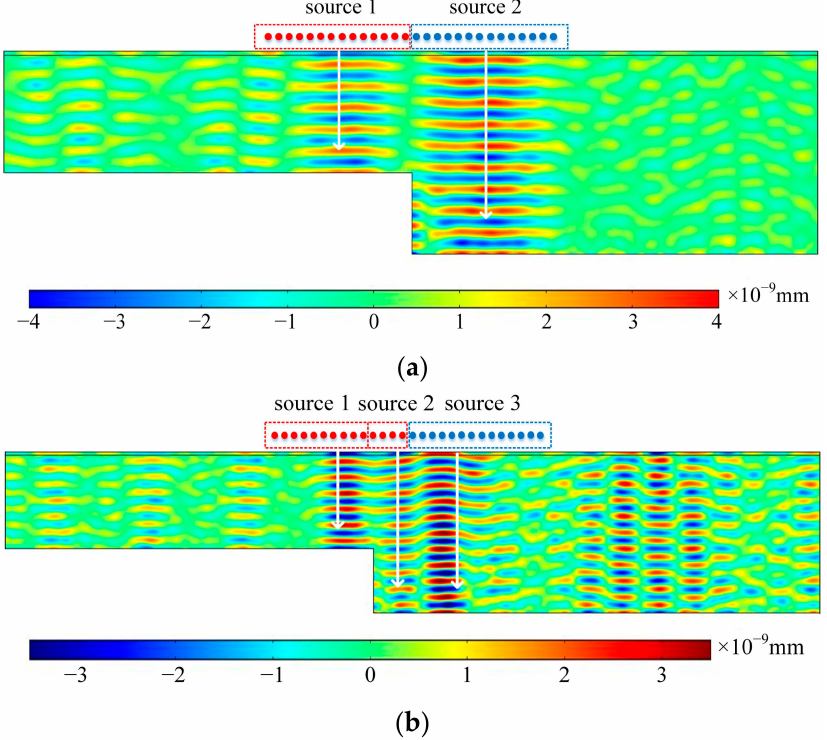
Figure 4. Non-resonant sound field diagram of transducer at f = 3.26 MHz. ( a ) Ultrasonic displace- ment distribution when coil group is located in the center. ( b ) Ultrasonic displacement distribution when coil area on both sides accounts for 30% and